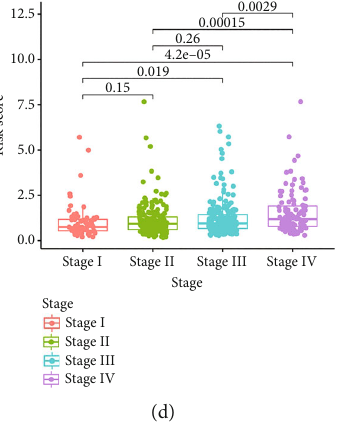
Figure 4: Relationship between risk pattern and clinicopathological characteristics of GC patients. (a) A heatmap was used to show the correlation between risk pattern and all clinicopathological characteristics of GC patients. (b) Correlation between risk score and tumor stage of GC patients. (c) Correlation between risk score and metastasis stage of GC patients. (d) Correlation between risk score and clinic stage of GC